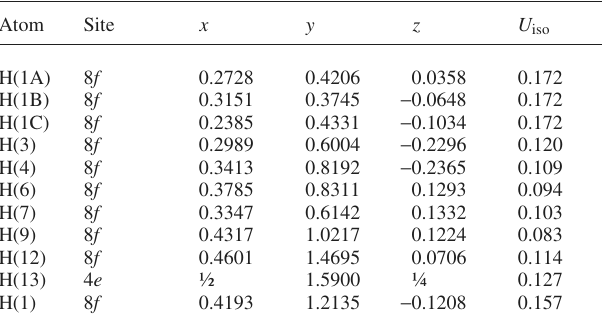
Table 2. Atomic coordinates and displacement parameters (in Å 2 ) .